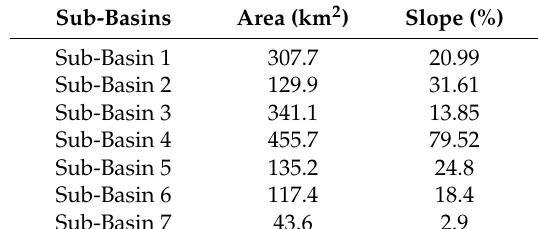
Table 1. Physiographic information of seven sub-basins in the Tamar Basin.